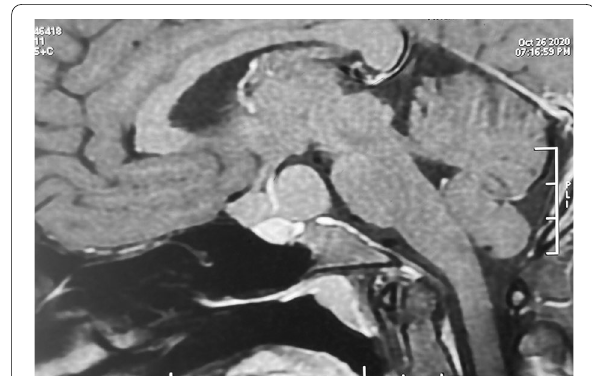
Fig. 5 MRI brain T1 contrast image showing mild peripheral enhancement of the lesion